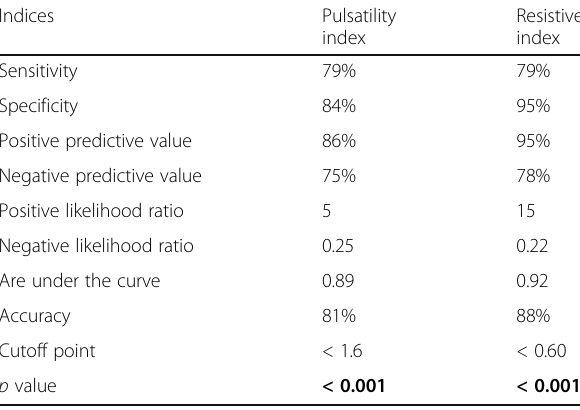
Table 3 Diagnostic performance of pulsatility and